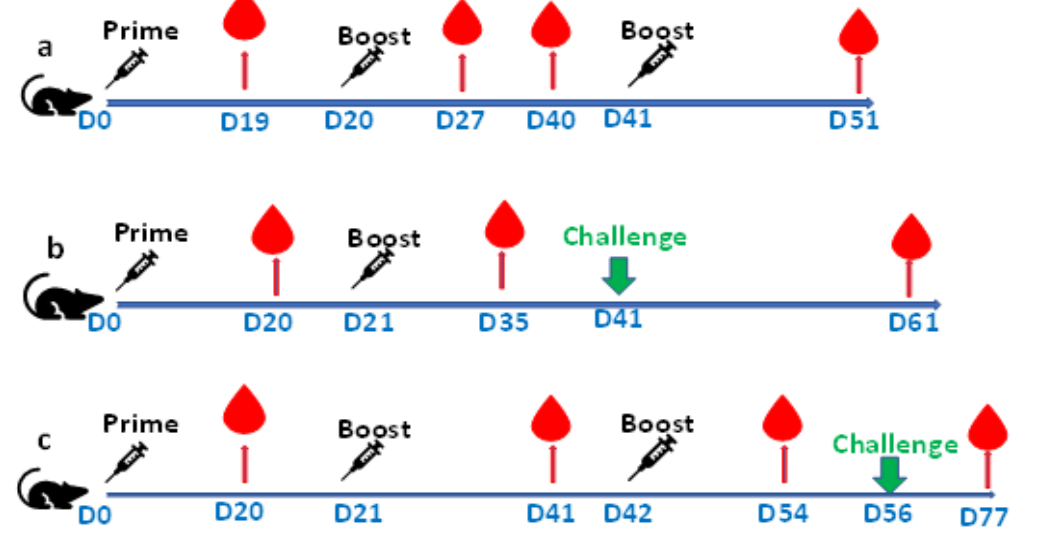
Figure 2. Vaccination of BALB/c (H-2 d ) female and K18-hACE2, C57Bl/6J (H-2 b ) female mice with affinity purified C1-RBD-C-tag adjuvated with Alhydrogel ® ‘85’: ( a ) three groups of BALB/c mice (10 per group) were injected subcutaneously (SC), with 20 µg of C1-RBD-C-tag/mouse adjuvanted with 320 µg, 500 µg, or 640 µg Alhydrogel ® ‘85’. As negative placebo controls, three groups of three mice were vaccinated with 320 µg, 500 µg, 640 µg Alhydrogel ® ‘85’ alone. All groups were primed and double boosted at 20 and 41 days post-prime, respectively; and ( b , c ) two groups of eight individual female K18-hACE2 C57BL/6J mice were primed and boosted either once ( b ) or twice ( c ) with 20 µg RBD-C-tag/mouse with 640 µg Alhydrogel ® ‘85’ at day 21 ( b ) and at days 21 and 42 ( c ). As negative controls, two groups of three individual K18-hACE2 C57BL/6J mice were each vaccinated with 640 µg Alhydrogel ® ‘85’ alone in the same manner as in ( b ) and ( c ). At 20 days post-injection with the 1 boost ( b ) and 14 days post the 2 boost ( c ) all C1-RBD-C-tag and control vaccinated mice were anesthetized and challenged Intra-Nasally (IN) with 2000 PFU of live SARS-CoV-2/mouse. General observations for monitoring morbidity and weight loss of the live virus challenged mice were carried out for three weeks post-challenge, and the final blood collection of all surviving mice was performed.